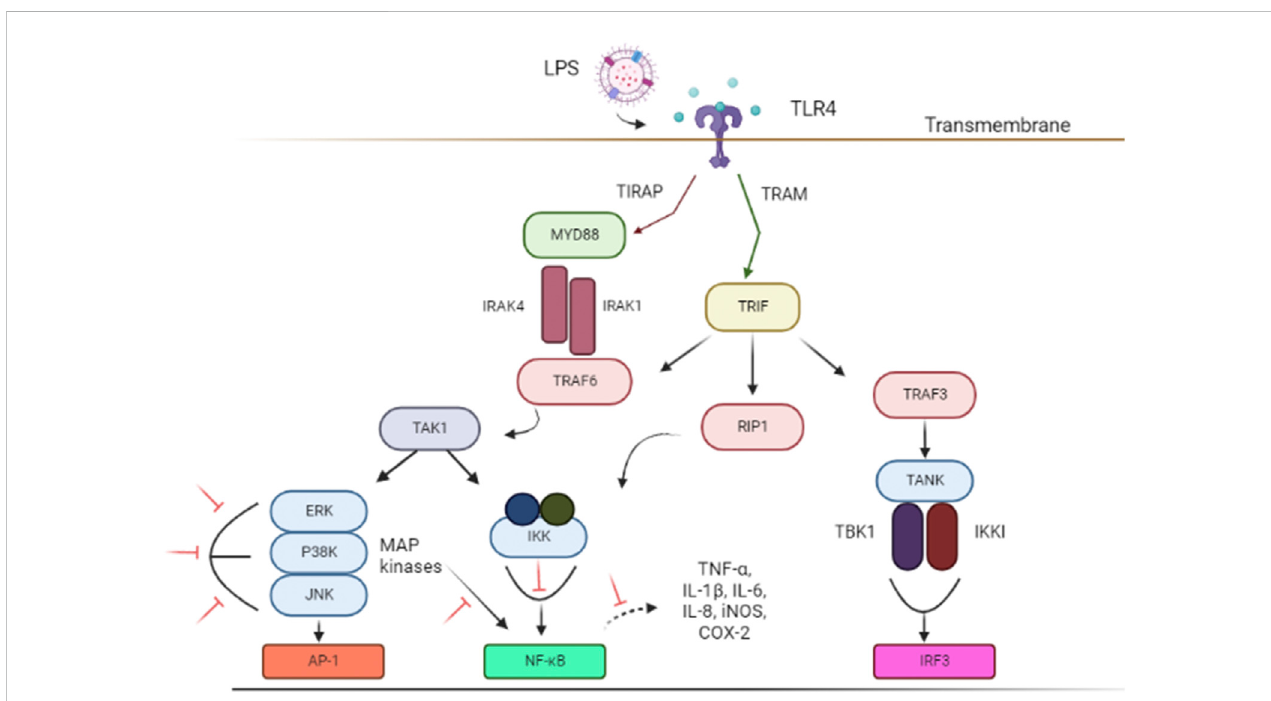
FIGURE 1 Schematic illustrations of associated signal transducing pathways in LPS-induced neuroin fl ammation via TLR4 signaling pathways. The inhibition of targetedsignaltransducingpathwaysisrepresentedbytheredlines.The fi gurewasadaptedandmodi fi edfromGribaretal.(2008),Luetal.(2008)andJantan et al. (2021). The fi gure was created with Biorender.com. Abbreviations: AP-1, Activator protein 1; COX-2, Cyclooxygenase-2; ERK, extracellular signal- regulatedkinase;IL,interleukin;IRF3,IFNregulatoryfactor3;iNOS,Nitricoxidesynthase;IKKi,kinaseIkappaBkinaseI;IKK,inhibitorofnuclearfactor- κ B (NF- κ B) kinase; IRAK1, interleukin-1 receptor-associated kinase 1; IRAK4, interleukin-1 receptor-associated kinase 4; JNK, c-Jun N-terminal kinase; LPS, Lipopolysaccharides; MYD88, Myeloid differentiation primary response 88; NF- κ B, nuclear factor kappa light chain enhancer of activated B cells; P38 MAPK, P38mitogen-activatedproteinkinase;RIP1,receptor-interactingserine/threoninekinase1;TLR4,Toll-likereceptor4;TRIF,TIR-domain-containingadapter- inducing interferon- β ; TIRAP, Toll-interleukin 1 receptor (TIR) domain-containing adapter protein; TRAF3, TNF receptor-associated factor 3; TRAM, TRIF- related adaptor molecule; TRAF6, Tumor necrosis factor (TNF) receptor-associated factor 6; TAK1, Transforming growth factor beta-activatedkinase 1; TNF- α , Tumor necrosis factor-alpha; TANK, TRAF family member-associated NF-kappa-B activator; TBK1, TANK Binding Kinase